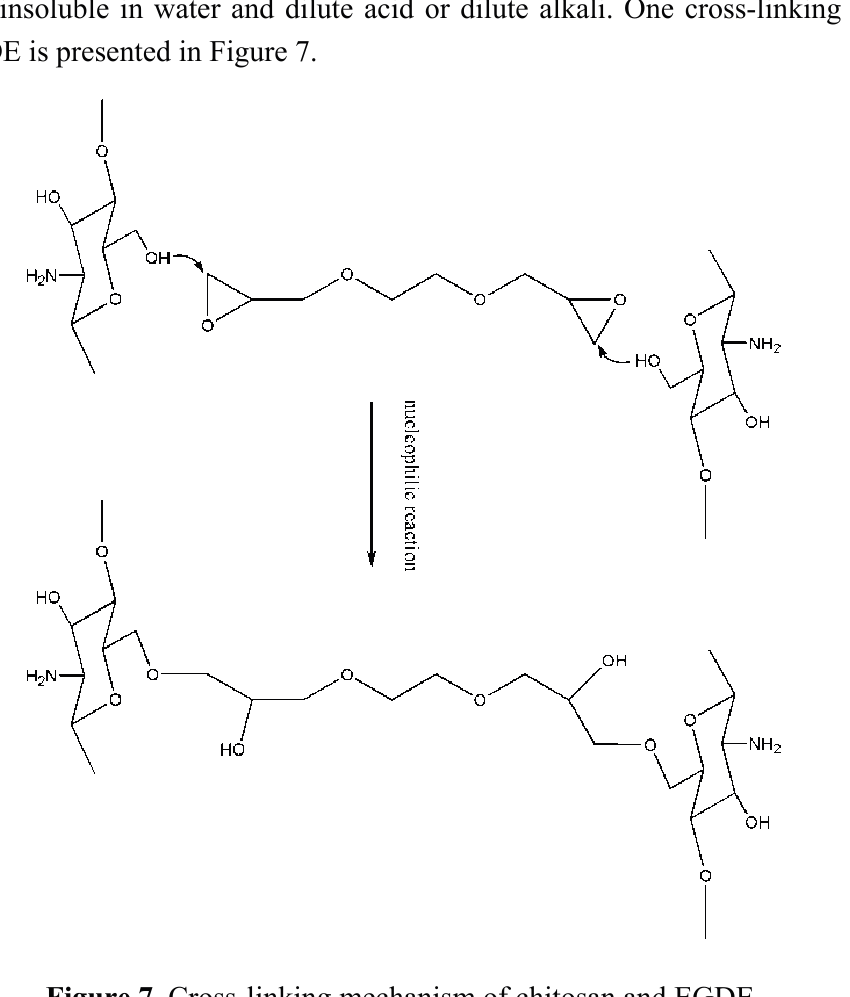
Figure 7. Cross-linking mechanism of chitosan and